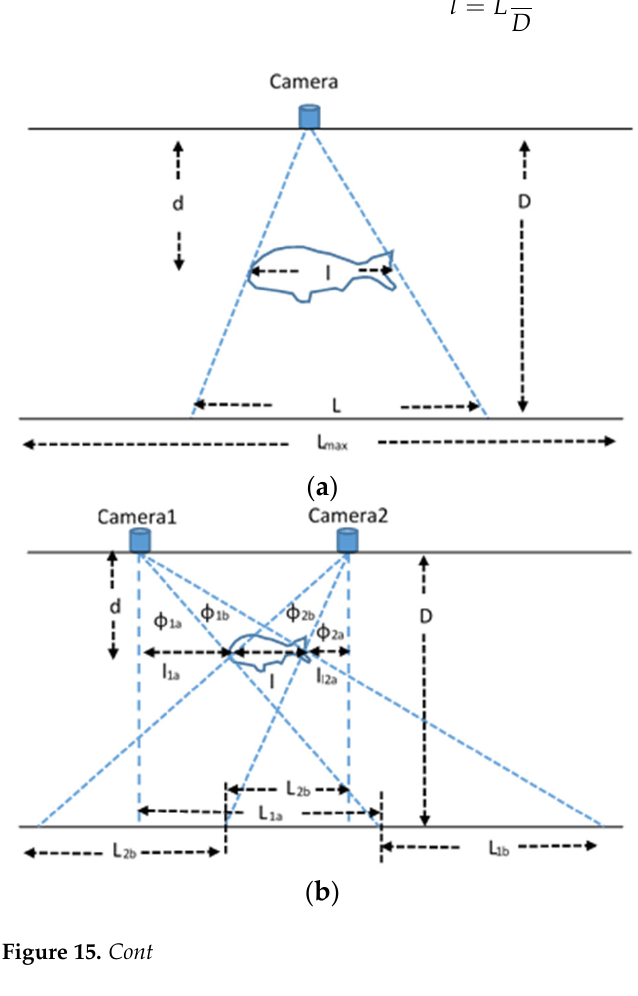
Figure 15. An example of a BMA mask ( a ) and the input image with annotated landmarks and colored fish parts that is generated as the output of the deep learning approach ( b